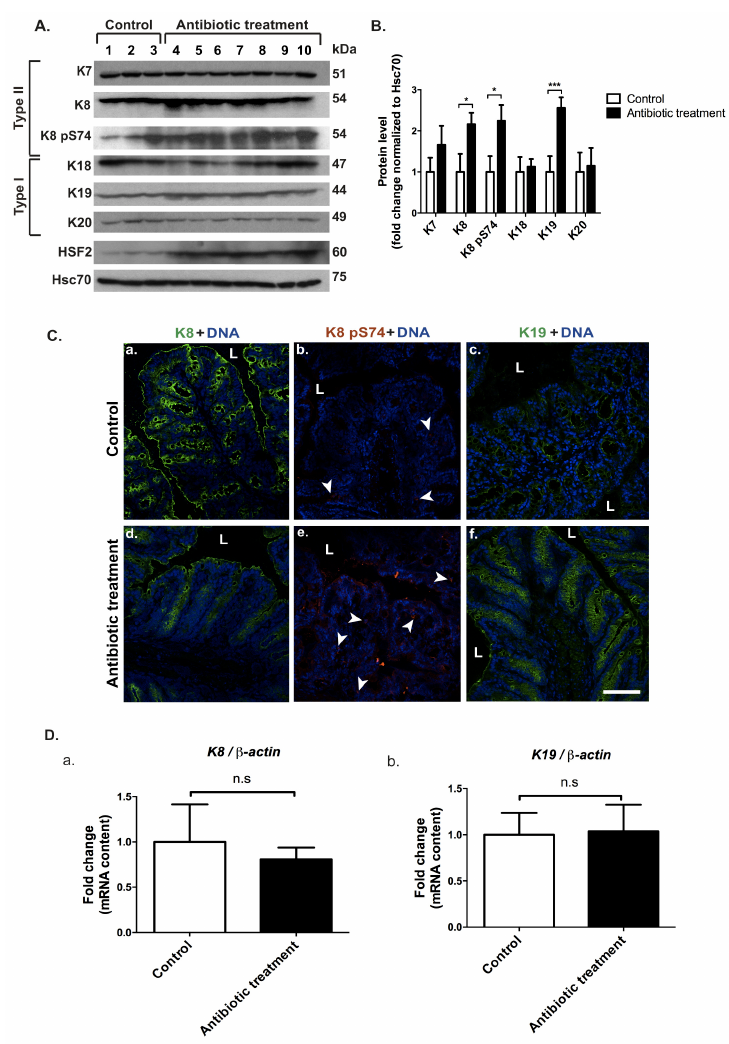
Figure 4. K8 and K19 are upregulated after the depletion of microbiota by oral antibiotic treatment. Mice ( n = 3 for controls, lanes 1–3 in ( A ), n = 7 for antibiotic-treated, lanes 4–10 in (A); strain FVB/n) were treated with or without oral broad-spectrum antibiotics for 56 days and samples for protein, RNA and immunofluorescence analysis were collected at the end of the treatment. The samples were then analyzed to assess changes in keratin levels in response to the depletion of microbiota. ( A , B ) The levels of the main colonic keratins K8 and K19 were upregulated after antibiotic-treatment, along with increased levels of stress-responsive HSF2 and K8 pS74 when quantified as in Figure 1 and shown as average ± SD. * p < 0.05, *** p < 0.001. ( C ) The increase of K8 (panel a, d in green), K19 (panel d, f in green) and K8 pS74 (panel b, e in red arrow heads) after antibiotic-treatment was confirmed by confocal microscopy. Nuclei (DNA) are shown in blue. L = lumen, scale bar = 50 μ m. ( D a,b) Gene transcription analysis of K8 ( D a) and K19 ( D b) normalized to β -actin showed no significant changes. n.s = not significant. Numerical data are shown as average ± SD. Statistical significance for Western blot and mRNA data was determined by t-test.